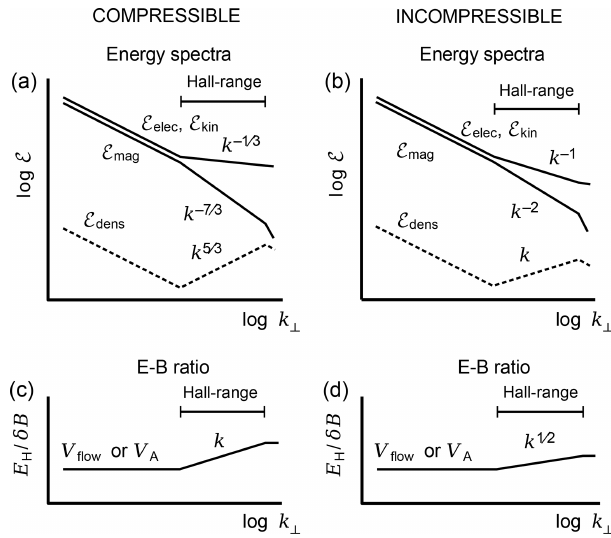
Figure 1. Panels (a) and (b) show the energy spectra for the mag- netic field ( E mag ), the Hall electric field ( E elec ), and the flow veloc- ity ( E kin ), and the density fluctuation ( E dens ) for compressible mag- netic turbulence (a) and incompressible turbulence (b) . Panels (c) and (d) are the E – B ratio for compressible magnetic turbulence (c) and incompressible turbulence (d)